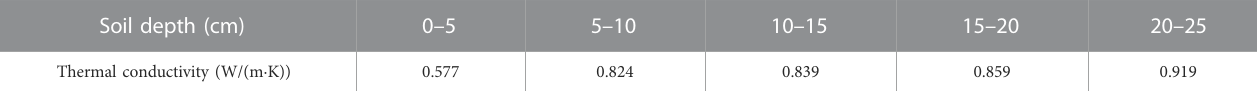
TABLE 3 Thermal conductivity of alpine meadow soil.